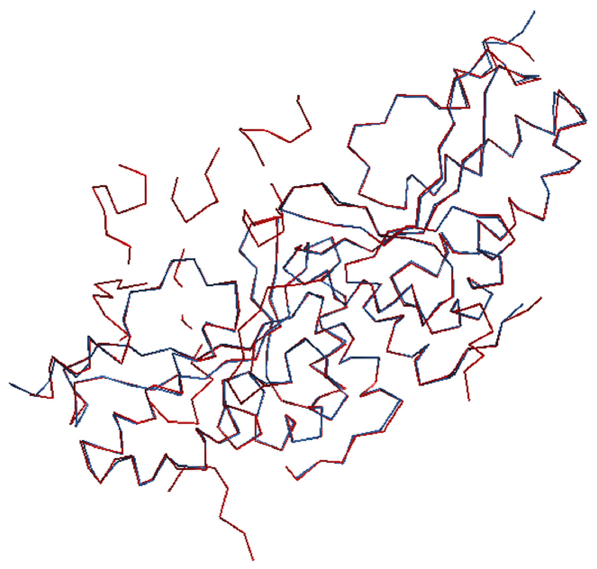
Figure 3. 2i3p, MA = 0.63. CAB chain-trace in red, published chain-trace in blue of the protein component. There are regions of the target asu in which CAB and the published backbones do not coincide.